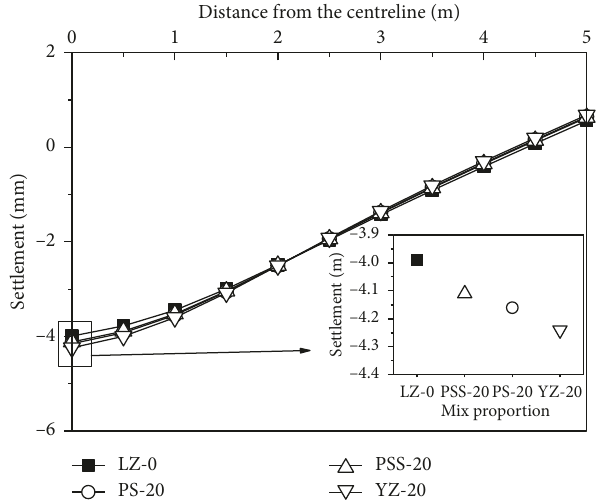
Figure 6: Settlement of the pavement with different base materials. Figure 7: Settlement of the pavement with different roadbase